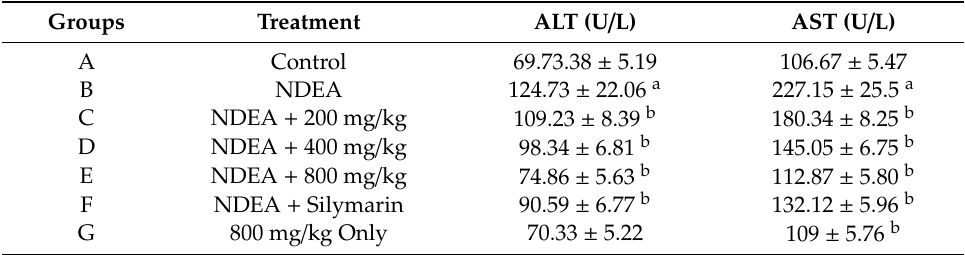
Table 2. E ff ect of Cajanus cajan on plasma AST and ALT